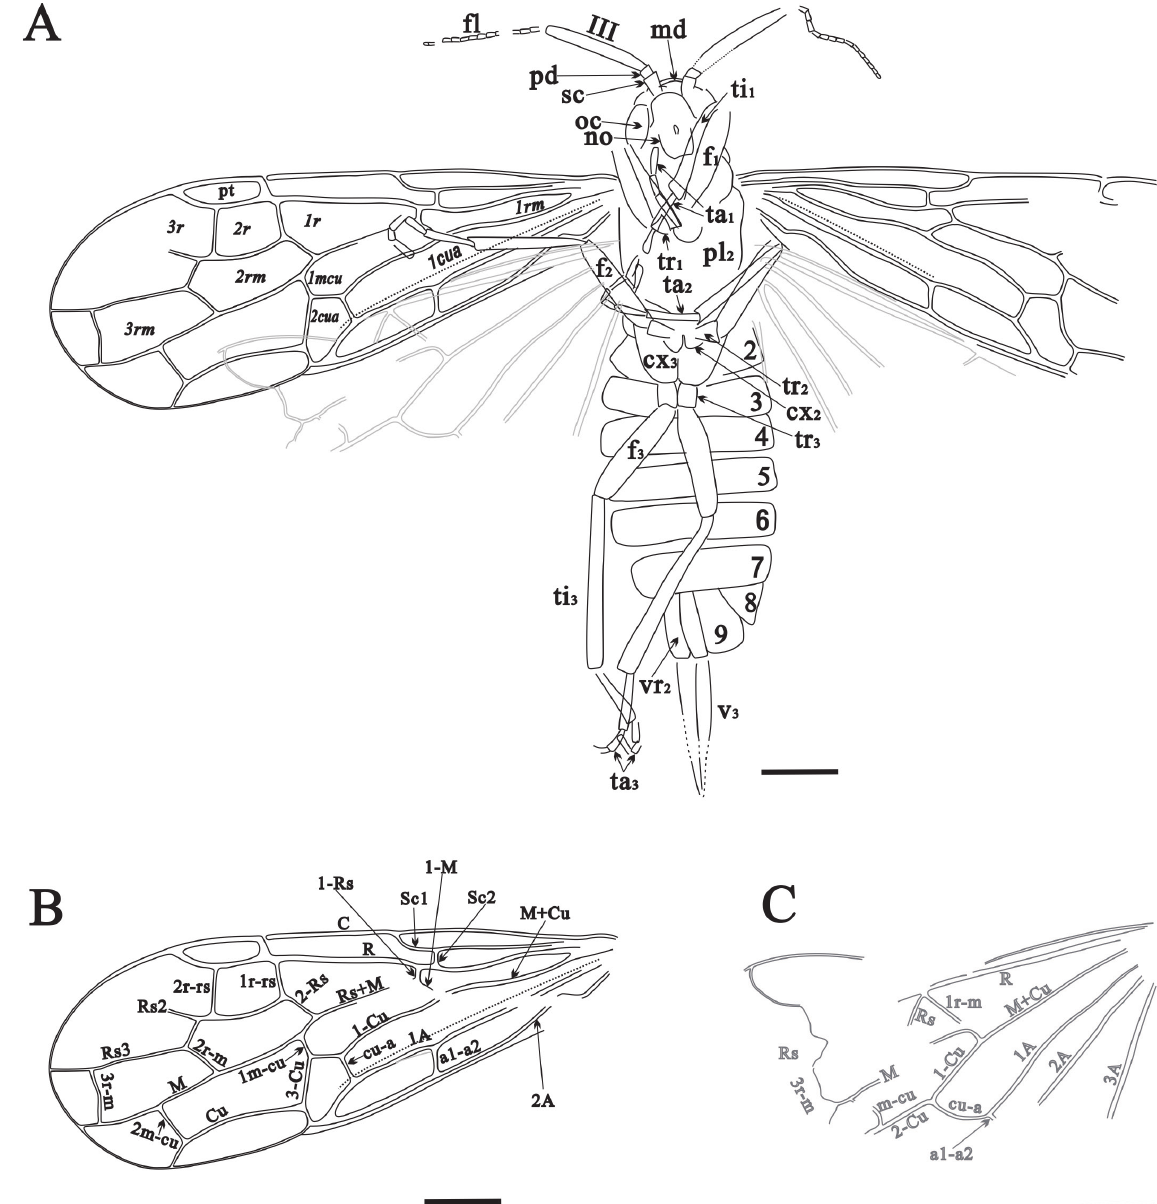
Fig. 3. Line drawings of Platyxyela tenuis sp. nov. A . Habitus, holotype. B . Left forewing. C . Left hindwing. Symbols: cx md = mandible; no = notaulus; oc = eye; pd = pedicel; pl fore, mid and hind tarsus; ti = ovipositor sheath; vr segment; venational symbols standard, names of wing cells italicised. Scale bars: 1